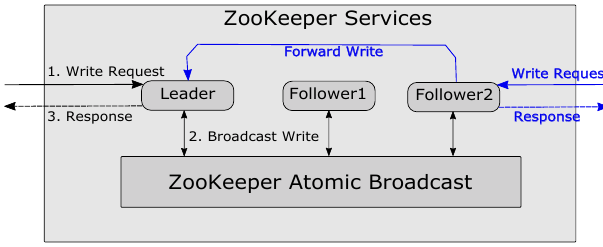
Figur e 1. Handling of Write Requests in